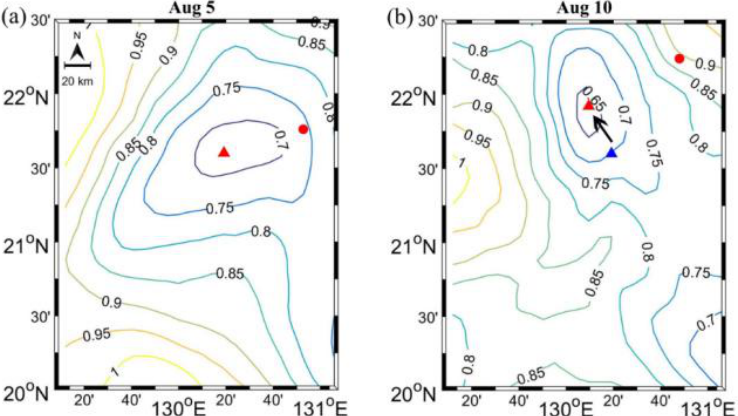
Figure 7. Same as Figure 5 but for SSH (unit: m) of HYCOM dataset, showing the position of the CE on 5 August ( a ) and 10 August ( b ) 2015. The relative position between the red dot and HYCOM determined eddy center (red triangle) is the same as that between Argo float and altimeter observed eddy center in Figure 5.